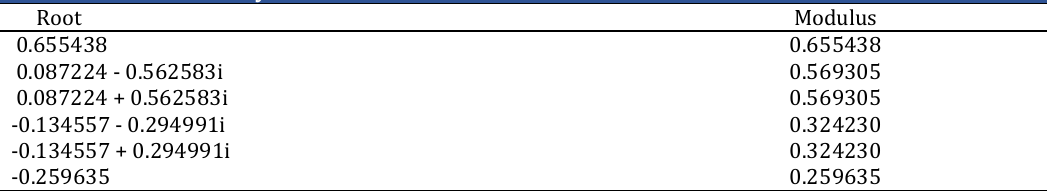
Table 4: Model stability test